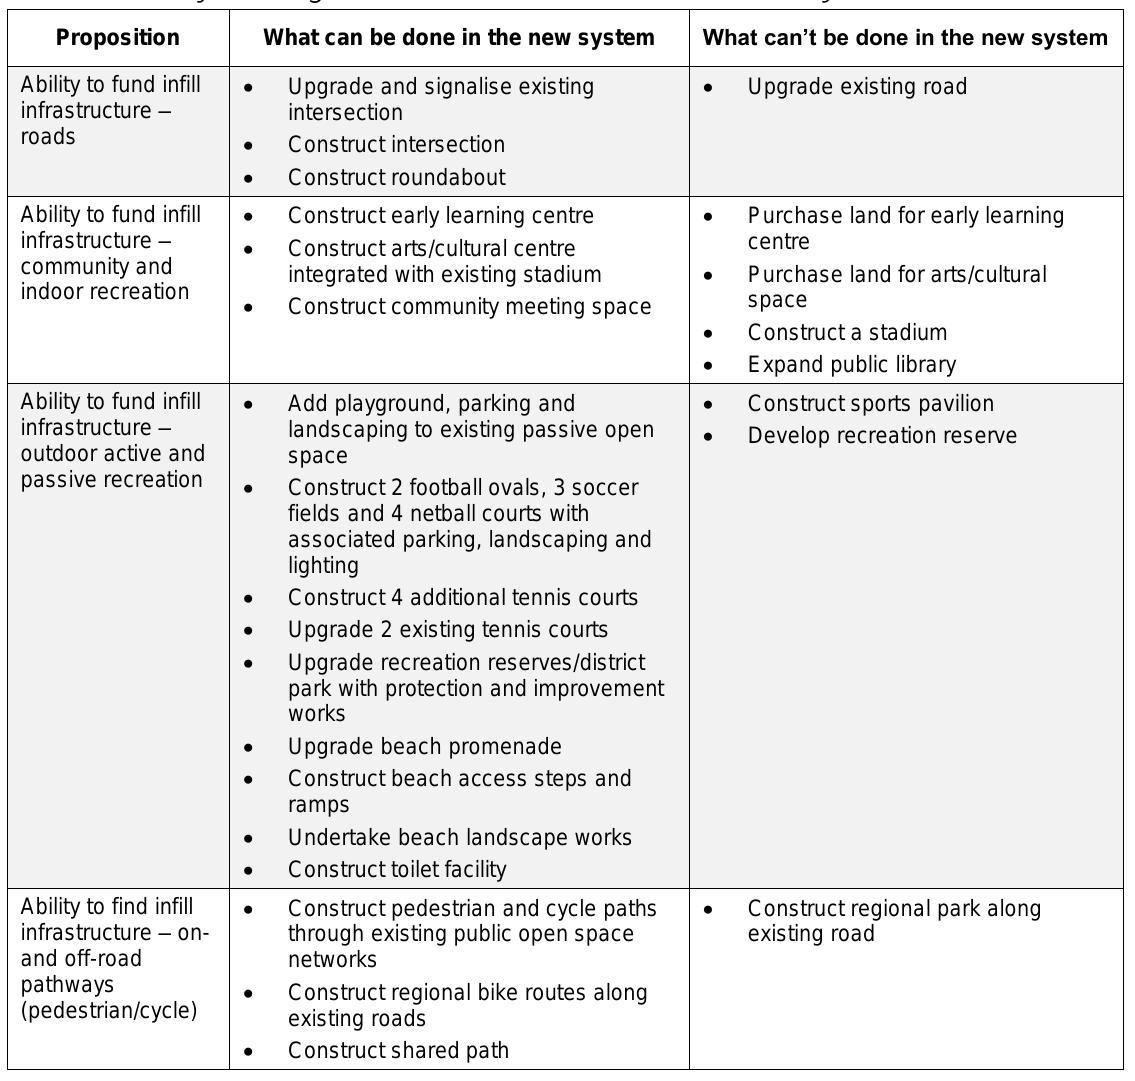
Table 4: Summary of findings from the Surf Coast Shire Council case